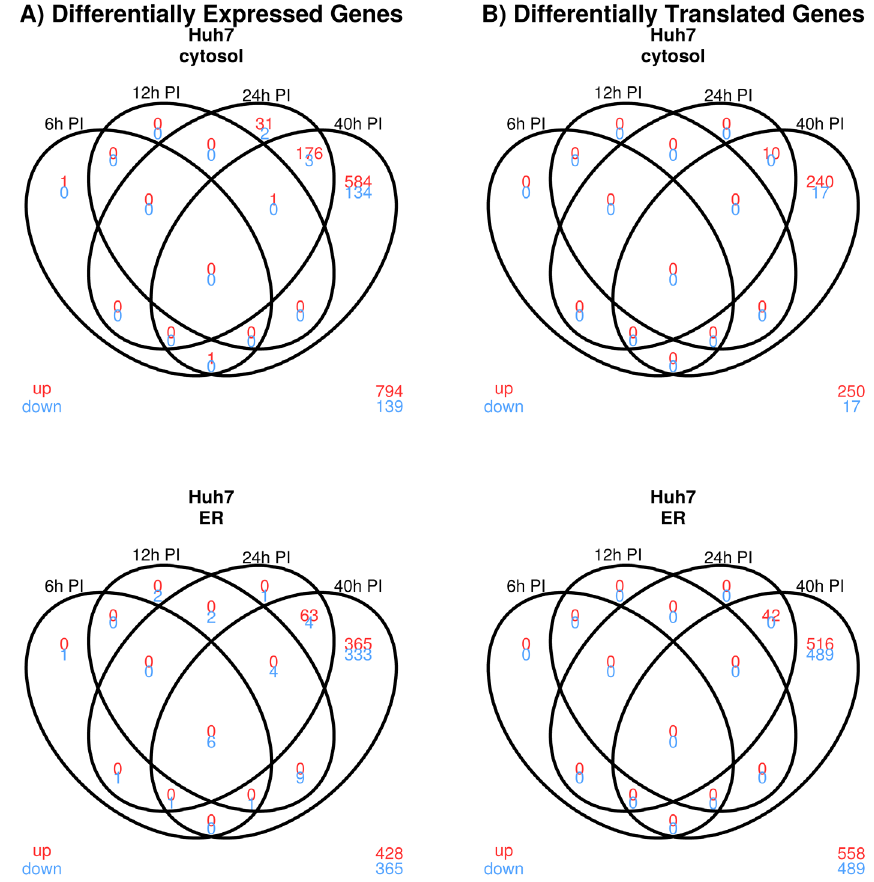
Figure 2. Dengue virus case study: Venn diagrams summarizing differential genes and transcripts following dengue virus (DNV) infection. In red: up-regulated relative to pre-DNV infection. In blue: up-regulated relative to pre-DNV infection. ER: endoplasmic